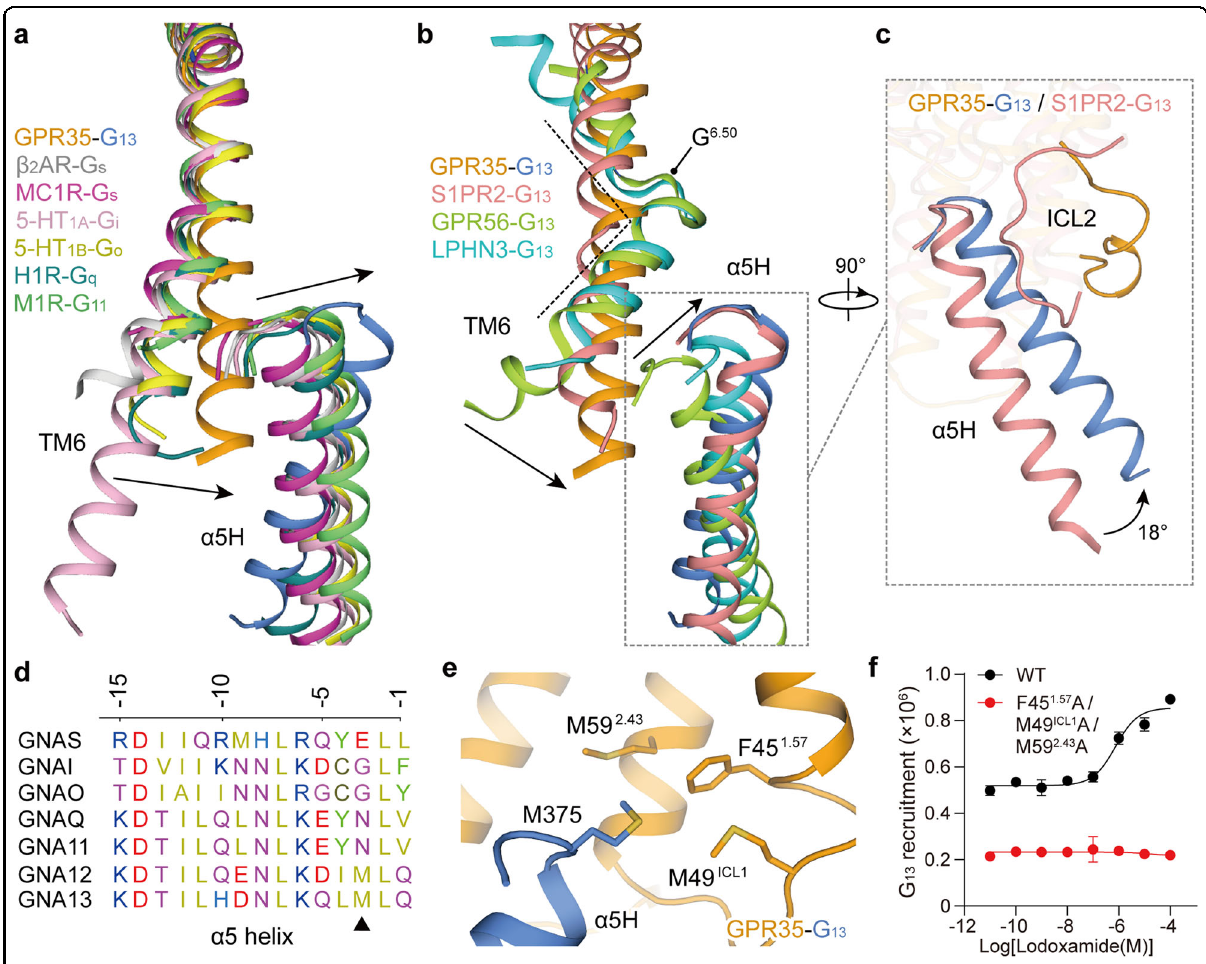
Fig. 5 Mechanism of GPR35 – G 13 coupling. a Structural comparison of the GPR35 – G 13 complex with representative class A GPCRs coupled to G s , G i/o , and G q/11 proteins, including the β 2 AR – G s (PDB: 3SN6), MC1R – G s (PDB: 7F4F), 5-HT 1A – G i (PDB: 7E2Y), 5-HT 1B – G o (PDB: 6G79), H1R – G q (PDB: 7DFL), and M1R – G 11 complexes (PDB: 6OIJ). b Structural comparison of the GPR35 – G 13 complex with reported G 13 -coupled GPCRs, including class A GPCR S1PR2 (PDB: 7T6B) and two adhesion (class B2) GPCRs, GPR56 (PDB: 7SF8) and latrophilin 3 (LPHN3, PDB: 7SF7). The movement orientations of the cytoplasmic end of TM6 and the extreme C-terminal end of α 5 helix of the G α subunit in the GPR35 – G 13 complex compared with those of other listed GPCR – G protein complexes are indicated by black arrows. The black dashed line indicates the sharp kink in GPR56 and LPHN3. The hinge residue G 6.50 was labeled. The GPCR – G protein complexes are colored as indicated. c The rotation of the α 5 helix of the GPR35 – G 13 complex relative to that of the S1PR2 – G 13 complex. The rotation angle of 18° is indicated by a black arrow. The rotation probably arises from the extensive contacts between S1PR2 ICL2 and the α 5 helix, which induces the noncanonical loop-like ICL2 to face inward towards the α 5 and its resulting rotation. d Sequence alignment of C-terminal sequences of α 5 helix of different G protein subtypes. The residues at the – 3 position are labeled by a black triangle. e The methionine pocket in GPR35. M375 ( – 3) of G 13 α 5 helix forms hydrophobic interactions with residues F45 1.57 , M49 ICL1 , and M59 2.43 , which constitute a